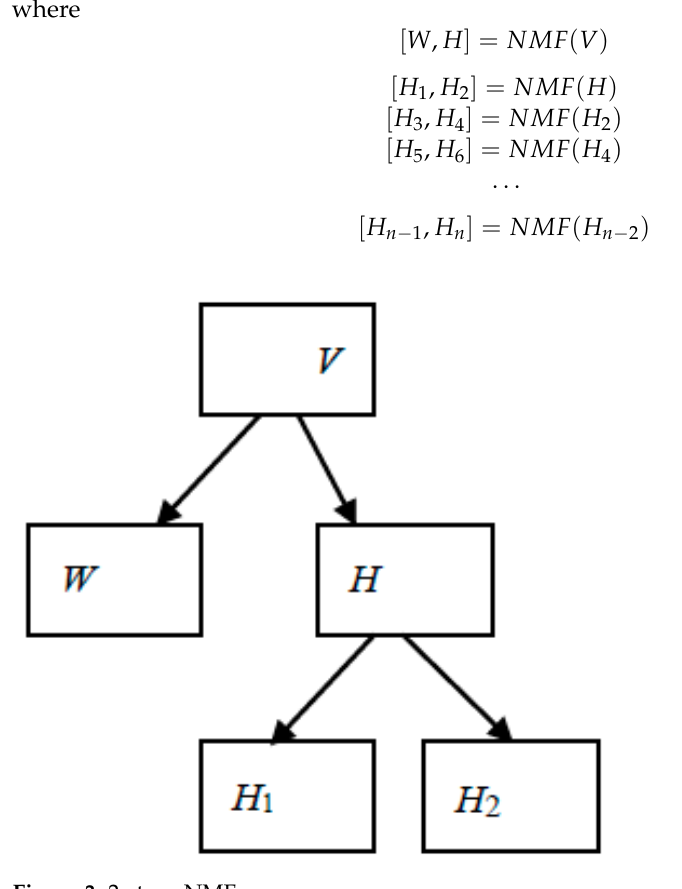
Figure 3. 2-stage NMF.